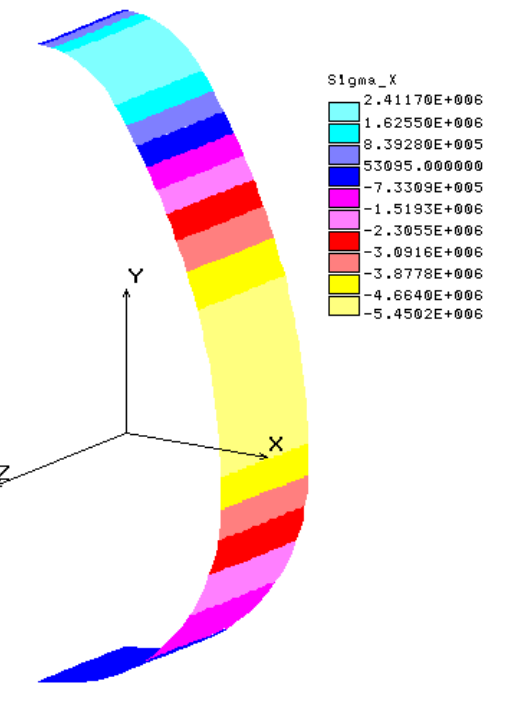
Fig. 3. Normal stresses (load scheme 1 – wall thickness equal to 19 mm)